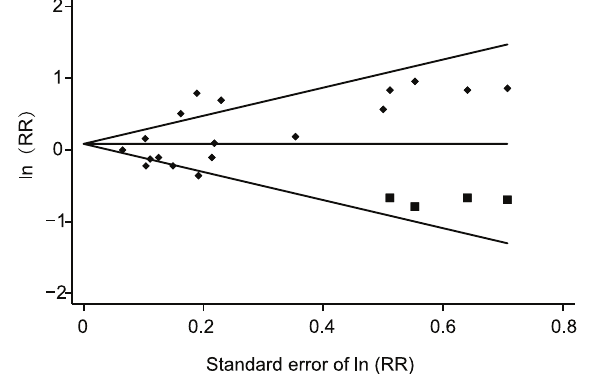
Figure 3. Funnel plot for case-control and cohort studies (dots: original data; squares: filled